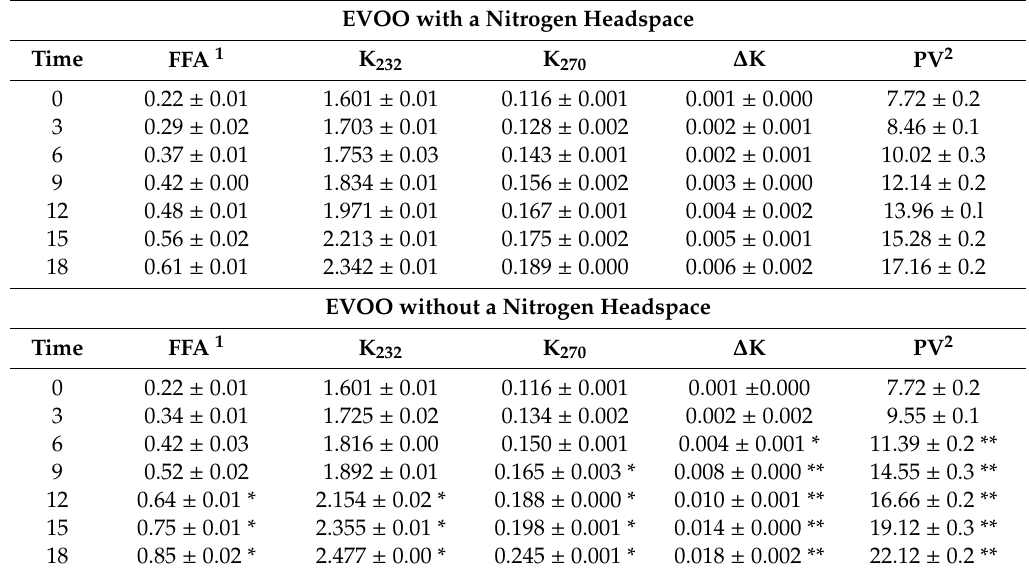
Table 2. Variations of the main physico-chemical properties of EVOOs with and without a